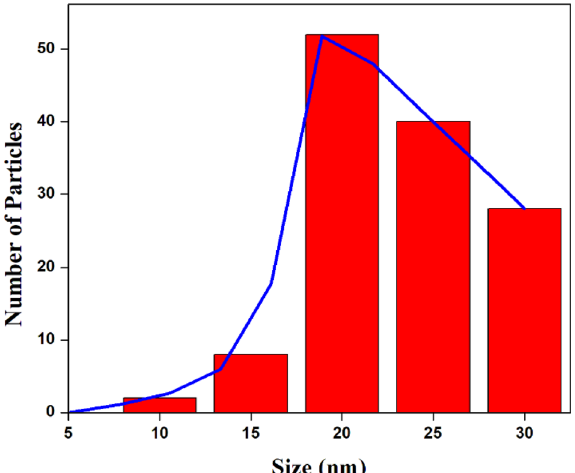
Figure 13. Particle size distribution histogram of NT1.